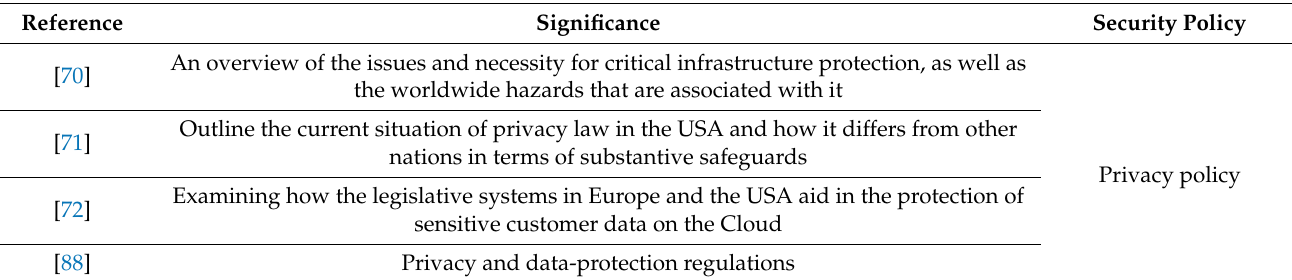
Table A1. Surveyed papers significance and